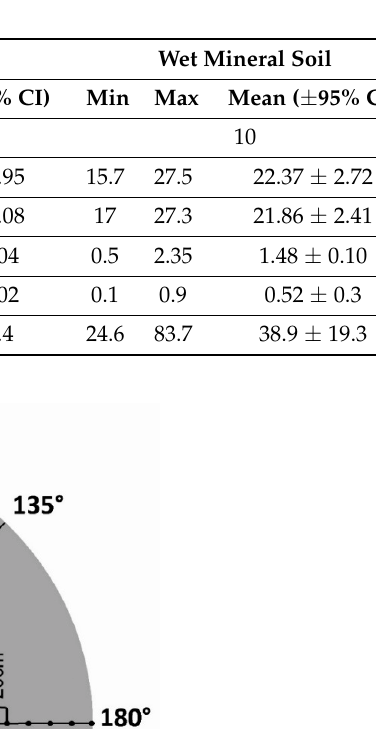
Figure 1. Root-soil plate measurement methodology [28] (light grey half-circle—root-soil plate surface; dark grey half-circle—tree stem; black dots—depth measurement points; black lines at cardinal directions—width measurement